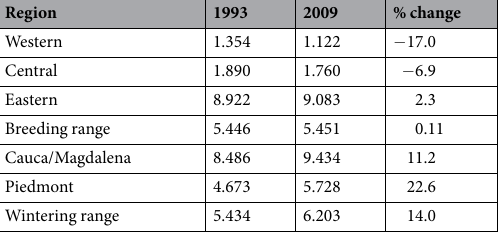
Table 3. Human footprint indices in 1993 and 2009 for the breeding and wintering ranges including the western, central and eastern breeding regions and the Cauca-Magdalena and Piedmont wintering regions in